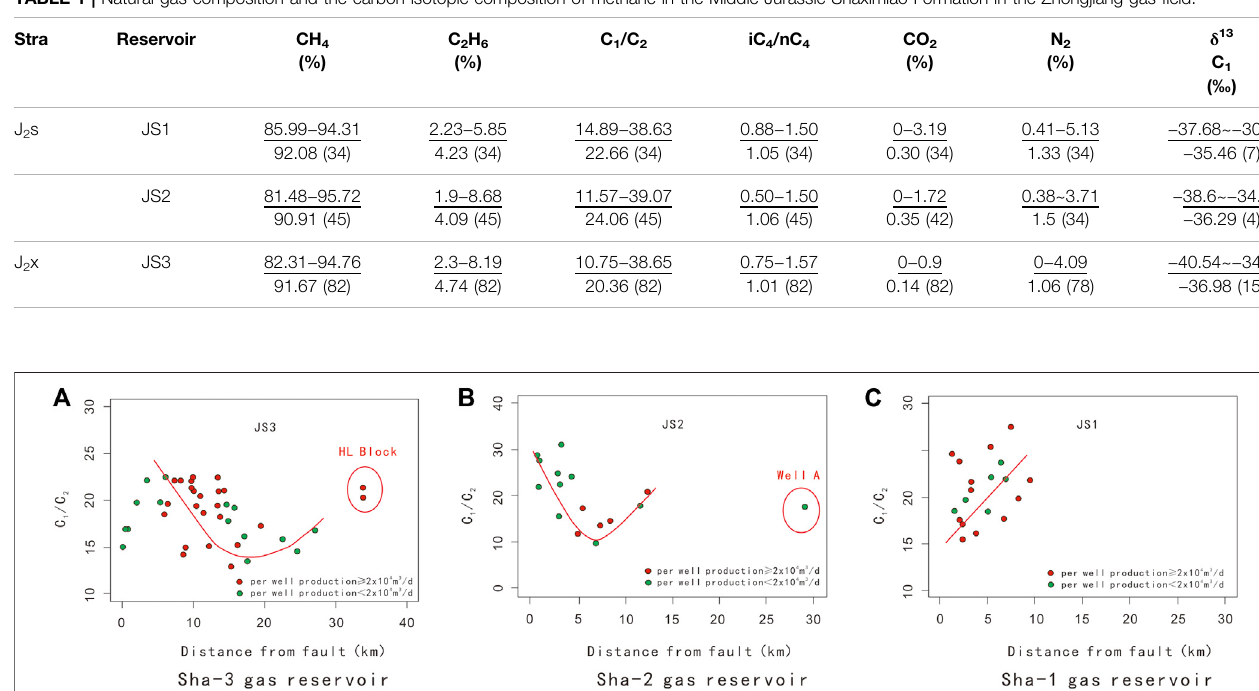
FIGURE 4 | Intersection of natural gas maturity (C 1 /C 2 ) values and distance from the fault in the Shaximiao Formation reservoir, Zhongjiang gas fi eld.